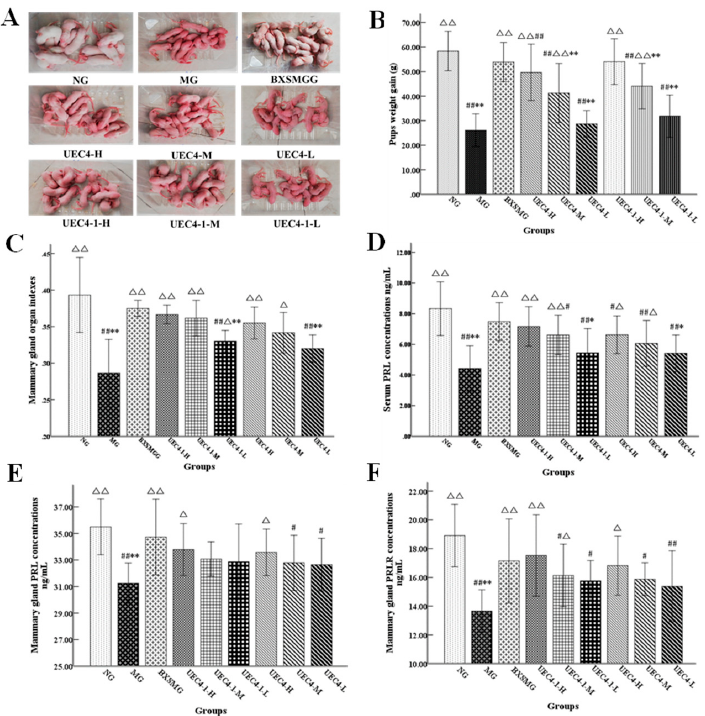
Figure 5. Effects of UEC4 and UEC4-1 on the indices of rats. ( A ) The growth of rats in each group.; ( B ) Comparison of body weight gain of offspring rats.; ( C ) Mammary gland organ indexes of female rats.; ( D ) Serum PRL concentrations of female rats.; ( E ) Mammary gland PRL concentrations of fe- male rats; ( F ): Mammary gland PRLR concentrations of female rats. # significantly different from the normal group at p < 0.05, ## significantly different from the normal group at p < 0.01; △ significantly different from the model group at p < 0.05, △△ significantly different from the model